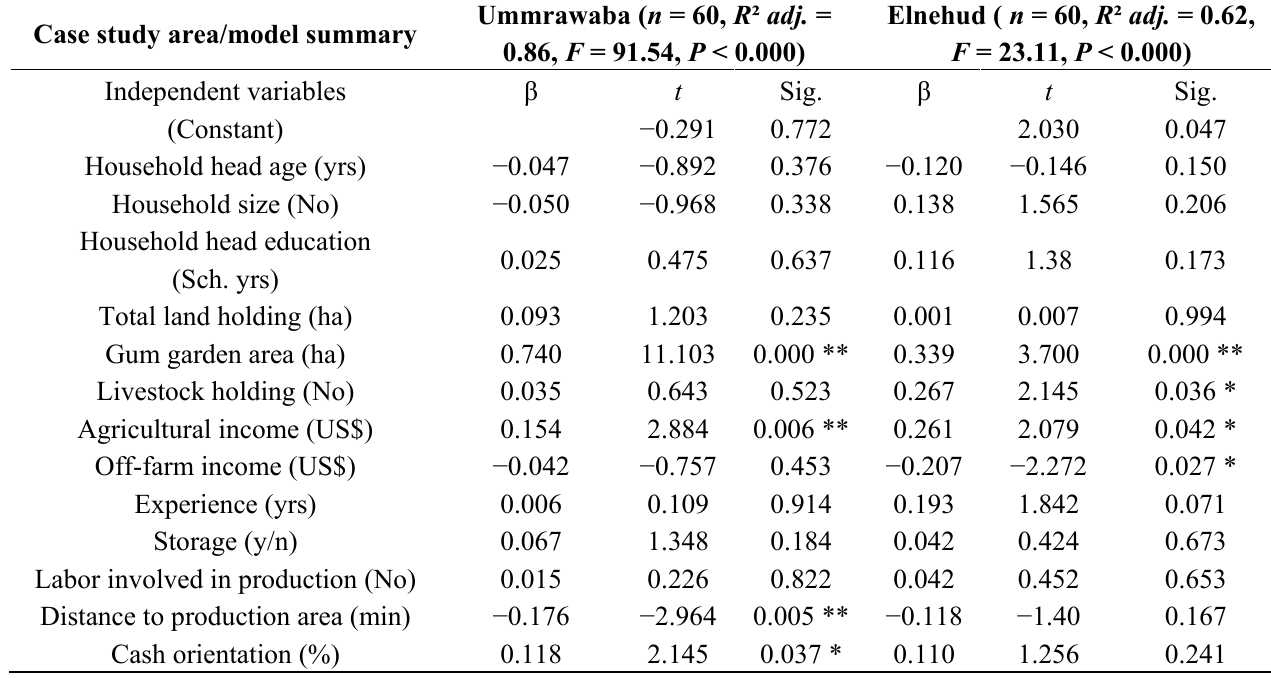
Table 6. Multiple regression analysis of gum and resin income against household socioeconomic characteristics and contextual variables, Ummrawaba and